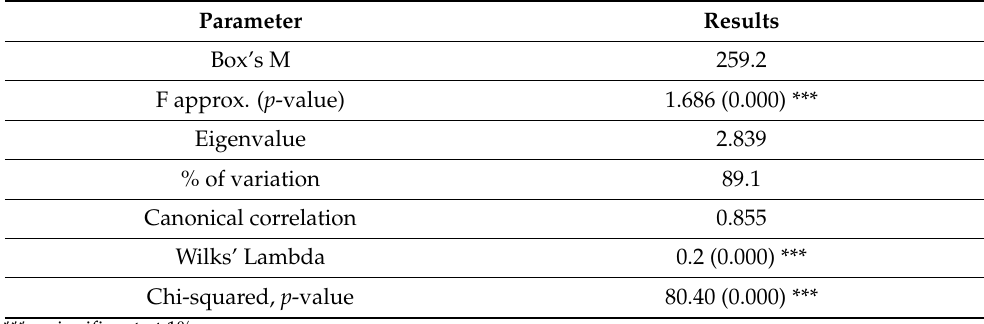
Table 4. The overall testing of the linear discriminant analysis